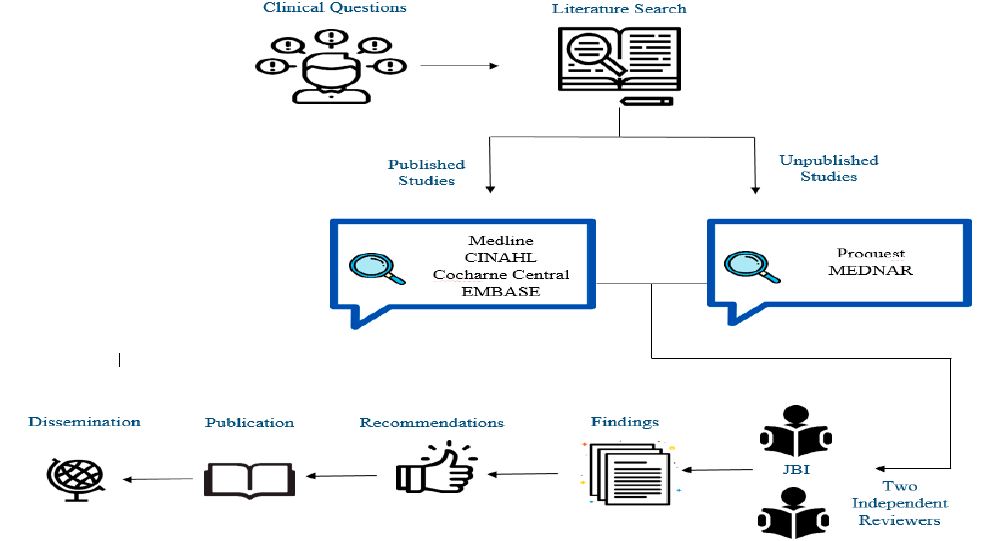
Figure 1. Literature searching and recommendations’ development framework.